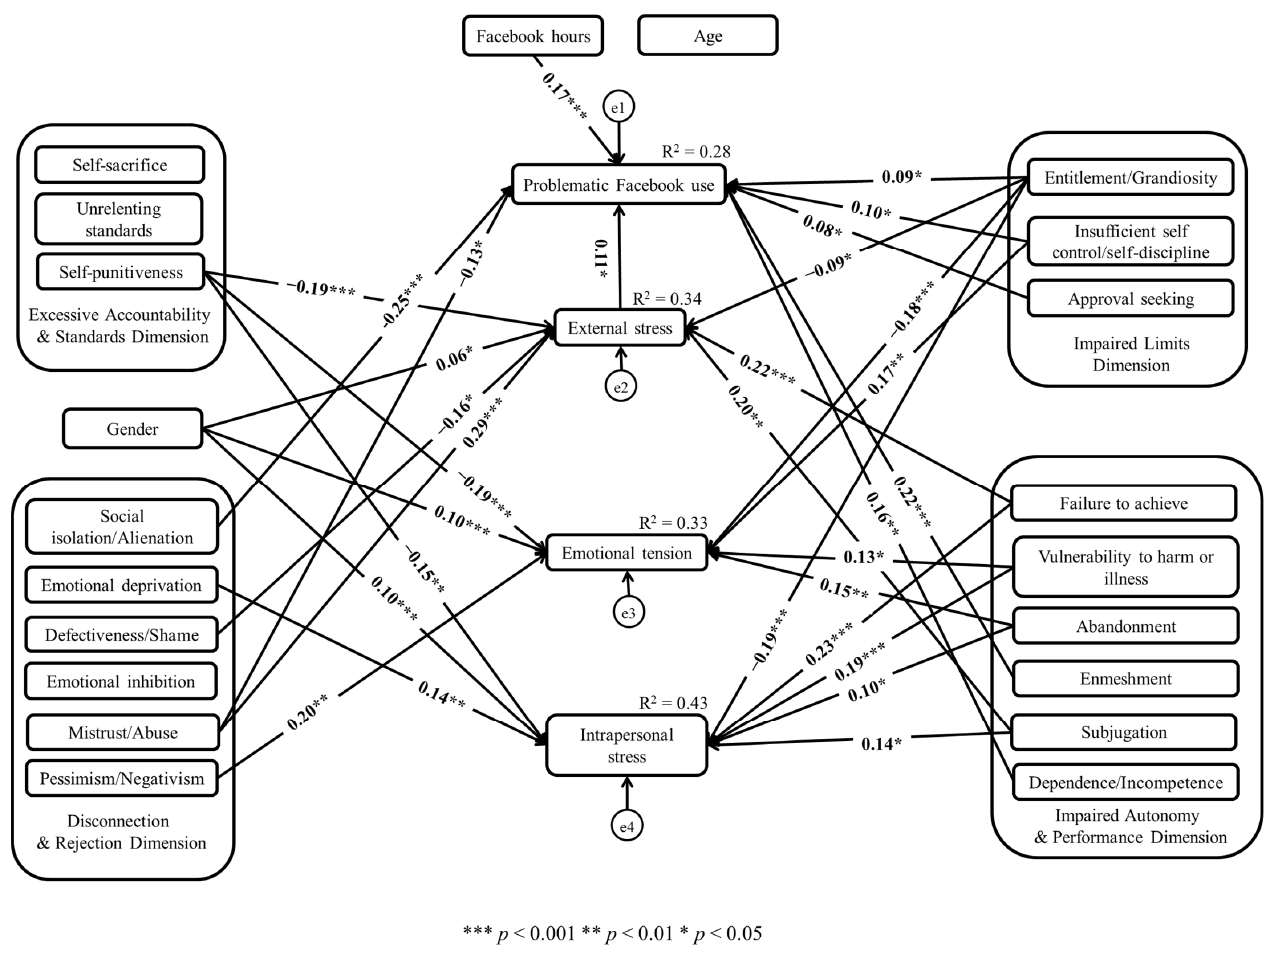
Figure 1. Statistically significant paths between analyzed